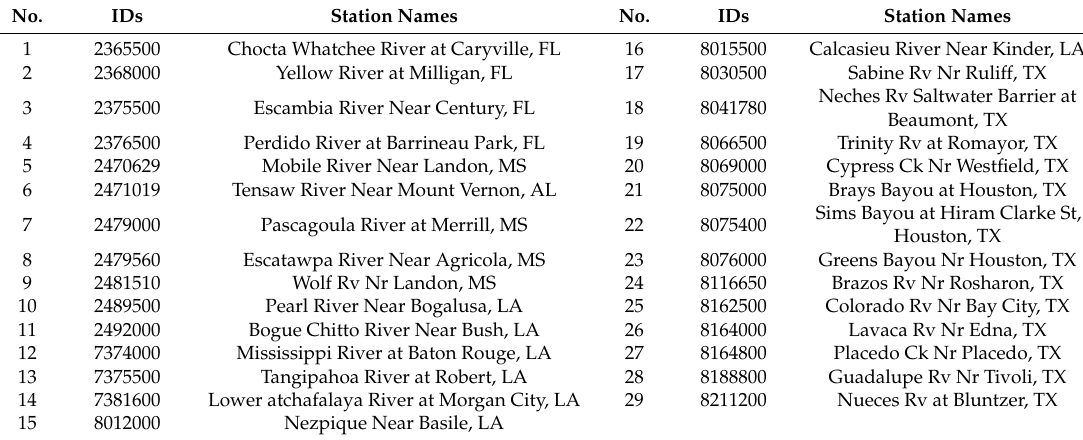
Table 2. USGS river station IDs and